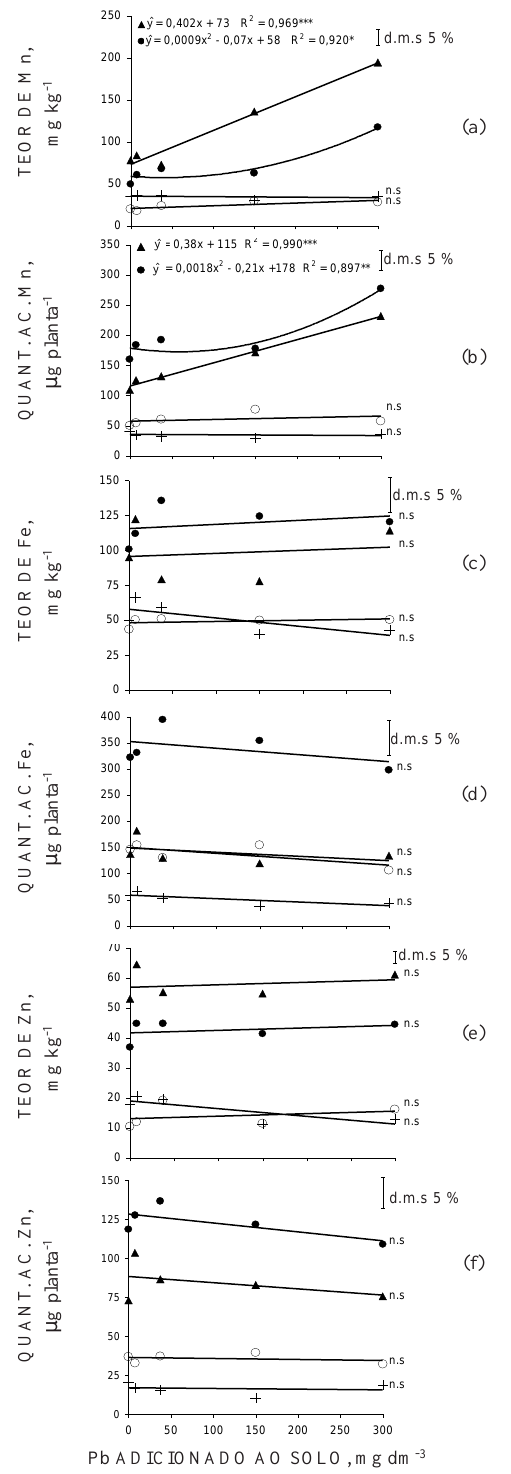
Figura 4. Teores e quantidades acumuladas de Mn (a,b), Fe (c,d) e Zn (e,f) na parte aérea da soja, considerando a dose de Pb adicionada ao solo ( com FMA e V = 63 %; sem FMA e V = 63 %; com FMA e V = 82 %; + sem FMA e V = 82 %). Valor do d.m.s a 5 % para comparar entre os FMAs e as V % dentro de cada dose de Pb (n.s: não- significativo; *p < 0,05; ** p < 0,01; ***p <